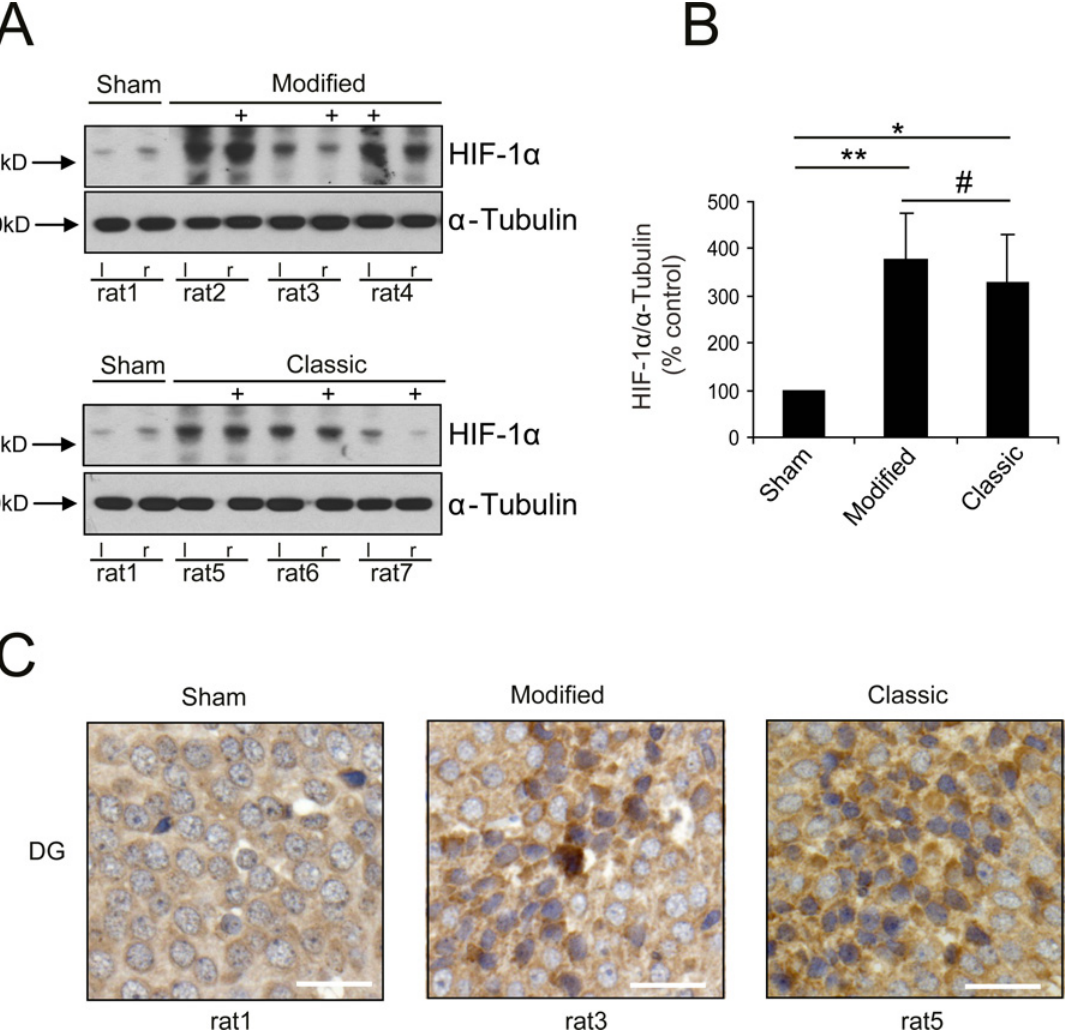
Fig 5. Analysis of HIF-1 α -expression. Protein analysis for HIF-1 α shows significant increase of HIF-1 α -expression in hippocampal tissue 6h after SAH (A +B) independent from type of technique (Location of ICP-probe is hallmarked (+)). Immunohistochemical staining for HIF-1 α demonstrates clear increase of HIF-1 α expression in dentate gyrus compared to Sham animal (right lower corner: bar indicates 20 μ m). ( ** p < 0.01; * p < 0.05; # p >